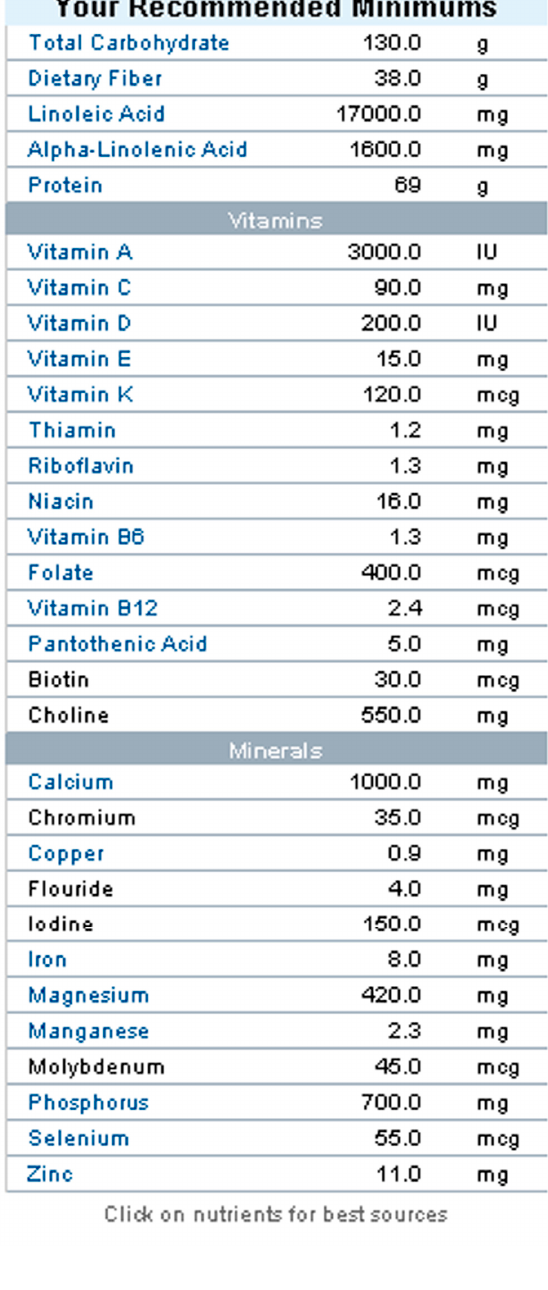
Figure 4. Recommended nutritional minimums for the person of the use case (values according to